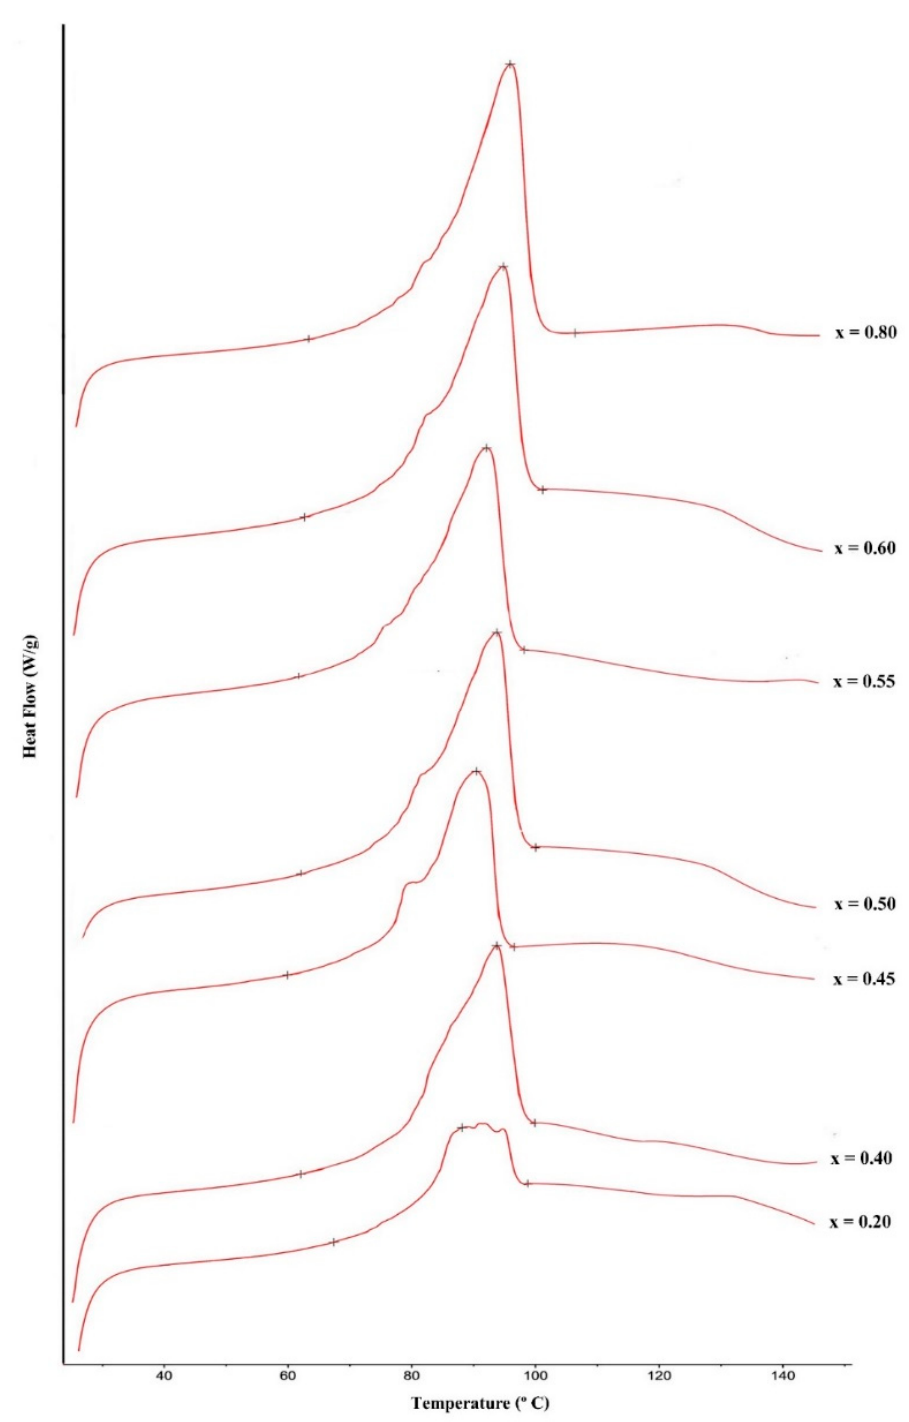
Figure 8. Thermogram of the xylitol-fructose system, where x was the mole fraction of xylitol. From the direct observation, the eutectic temperature was 79 °C, but from scanning calorimetry (see Figure 9), the eutectic temperature was 76.4 °C. Therefore, the difference in temperature between the experiment and DSC was 2.6 °C.